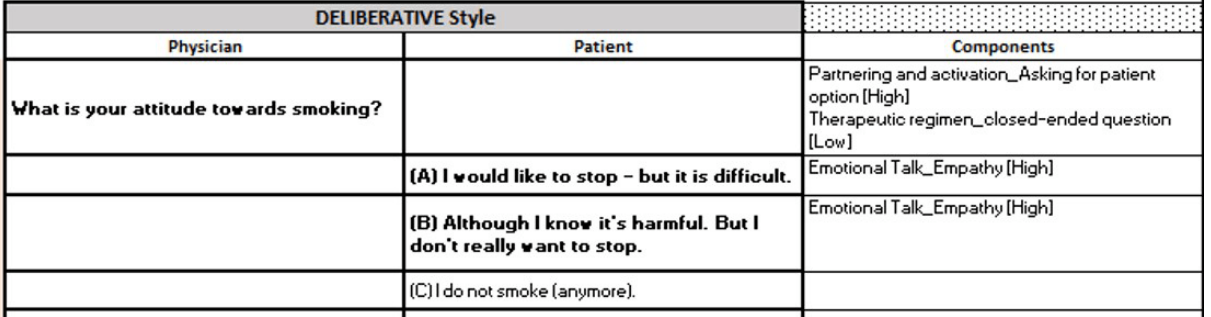
Figure 3. An example of the developed script for the deliberative version of the conversational agent Robo is shown here. Here, the answer options for patients, as depicted in the column “Patient,” deviated between the 2 conditions.